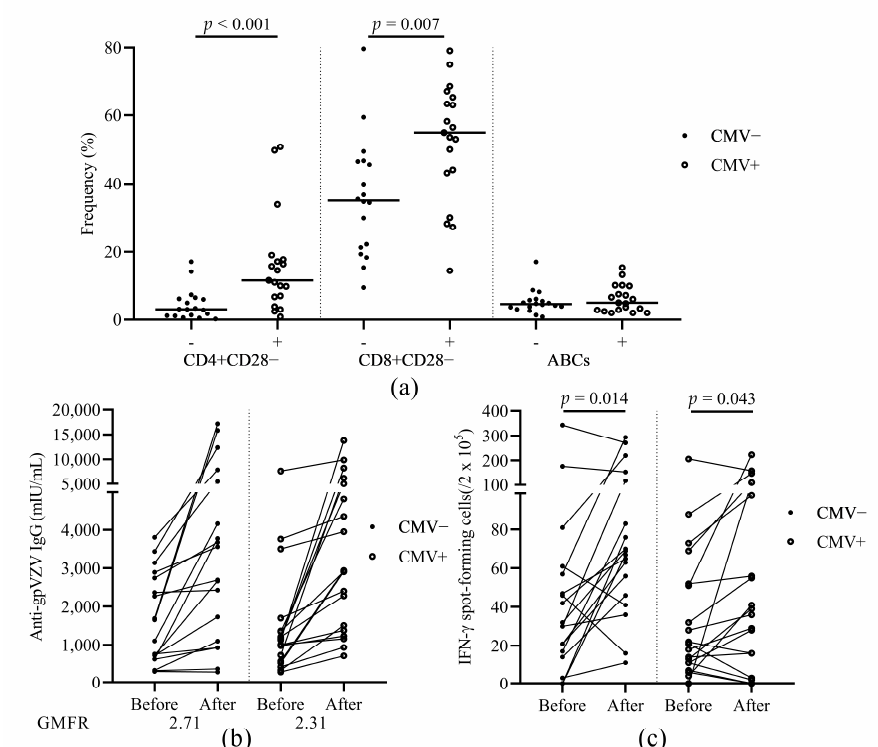
Figure 4. The effect of CMV serostatus on aged T/B cell subsets and immunogenicity of the HZ vaccine. ( a ) The frequencies of CD4+CD28−, CD8+CD28−, and ABCs before vaccination. ( b ) Levels of anti-glycoprotein (gp) VZV IgG antibody before and after vaccination. GMFR after vaccination over before vaccination is shown under the figure. ( c ) The number of VZV stimulated IFN-γ secreting T cell spots before and after vaccination. HZ, herpes zoster; gp, glycoprotein; VZV, varicella zoster virus; GMFR, geometric mean fold rise; ABCs, age associated B cells; cytomegalovirus, CMV. Patients were divided into subgroups according to their CMV